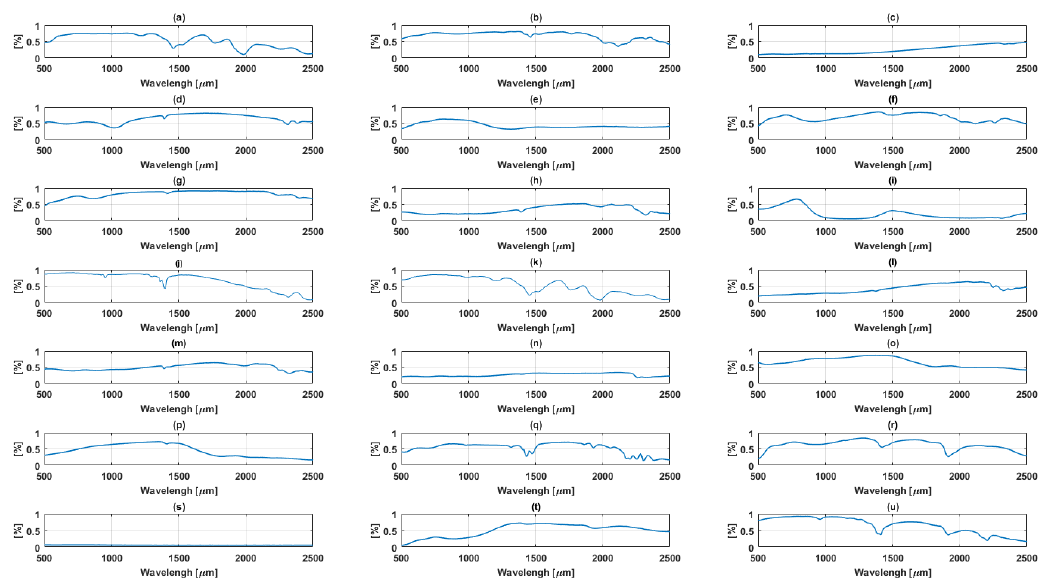
Figure 1. Spectral reflectance of endmembers of the simulated data plotted, reflectance [%] against wavelength ( a ) Brucite; ( b ) Clinochlore; ( c ) Axinite; ( d ) Erionite; ( e ) Ammonioalunite; ( f ) Clintonite; ( g ) Almandine; ( h ) Carnallite; ( i ) Actinolite; ( j ) Andradite; ( k ) Antigorite; ( l ) Elbaite; ( m ) Ammonio-jarosite; ( n ) Diaspore; ( o ) Halloysite; ( p ) Biotite; ( q ) Galena; ( r ) Carnallite; ( s ) Chlorite; ( t ) Goethite; ( u )